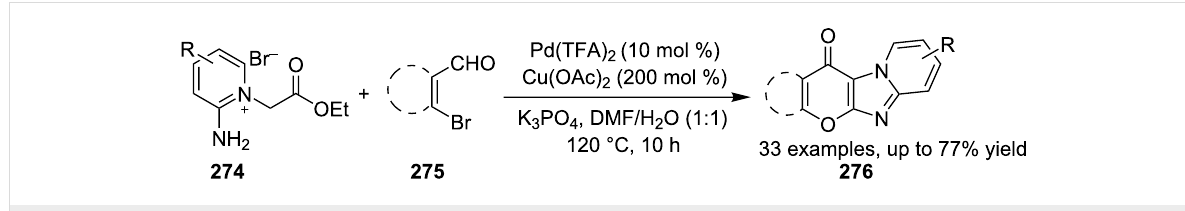
Scheme 92: Synthesis of chromenoannulated imidazo[1,2- a ]pyridines.